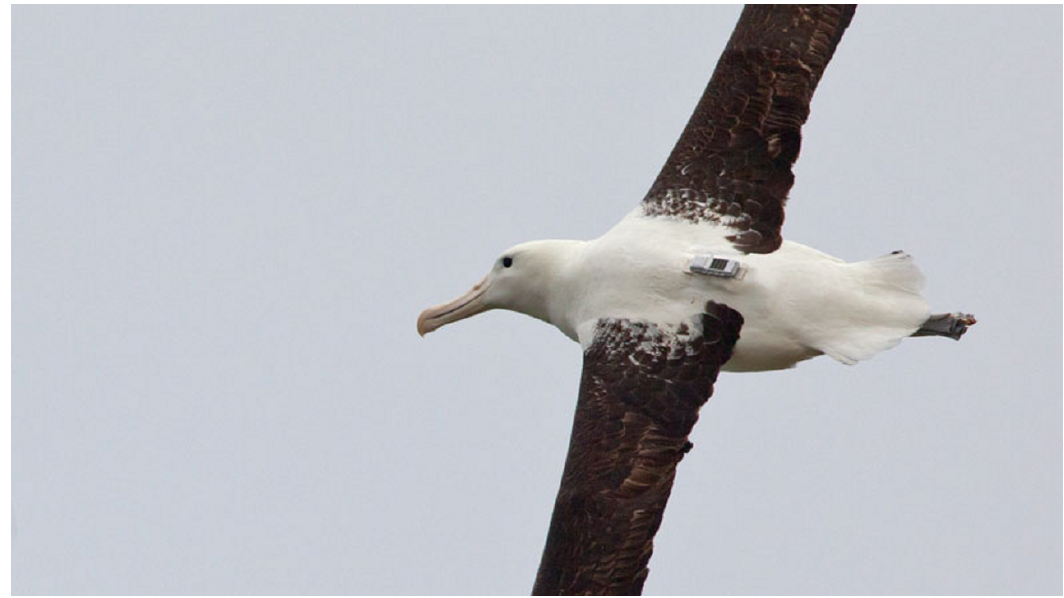
Figure 8. A solar-powered FastFix tag attached to the back of a Royal Albatross. This tag can store in a 2 GB SD-card approximately a quarter of a million fixes. Photo ©Keith Payne—used with permission.